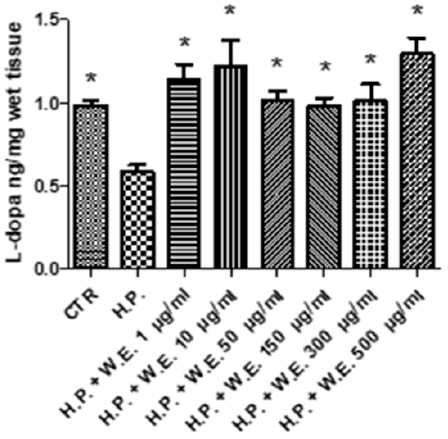
Figure 7. Inhibitory effect induced by Futura 75 water extract (W.E.) on L-dopa turnover increased by hydrogen peroxide (H.P.) 1 mM in isolated mouse skin specimens. ANOVA, p < 0.01; * p < 0.05 vs. H.P.